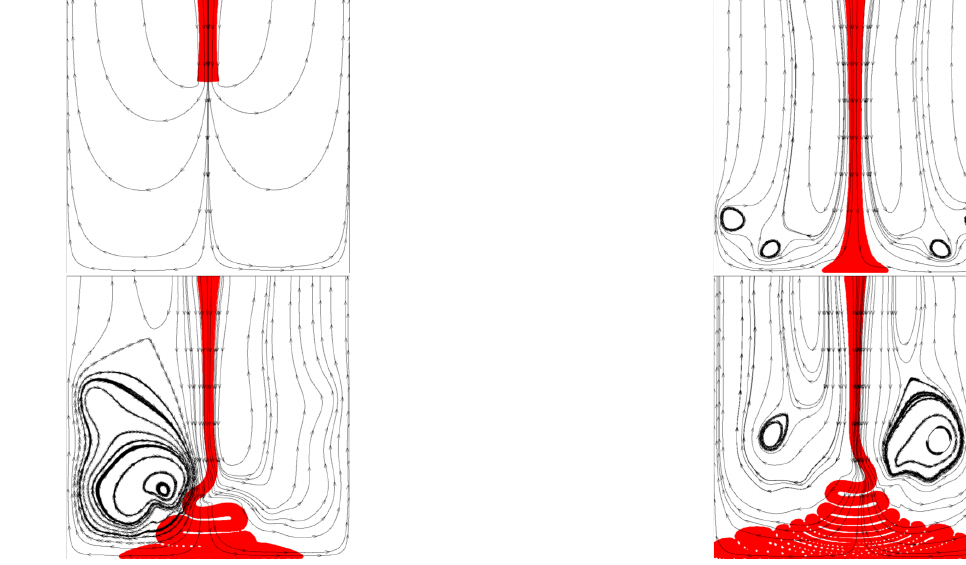
Figure 7. Numerical simulation of a viscous liquid (propergol) jet injected in a square cavity ( 1 m × 1 m ) on a 320 × 320 grid: the interface is plotted at time t = 0.25 s and 0.75 s (first row), t = 1.25 s and 2 s (second row). Test case 1 corresponds to Re = 0.1728.